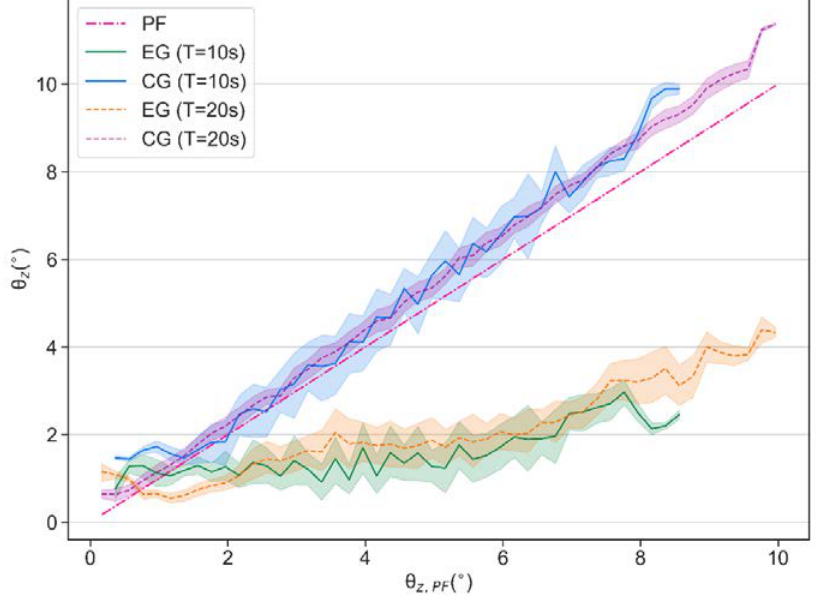
Figure 15. Tilt angles